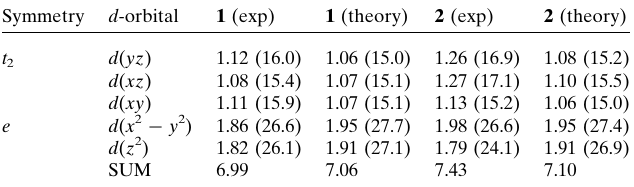
Table 5 Topological analysis of the electron density. First line is from 1 , second line from 2 . Units are eA˚ (cid:2) 3 for (cid:7) bcp , eA˚ (cid:2) 5 for r 2 (cid:7) bcp , A˚ for distances ( d ); and energy densities G , V and H are given in hartree au (cid:2) 3